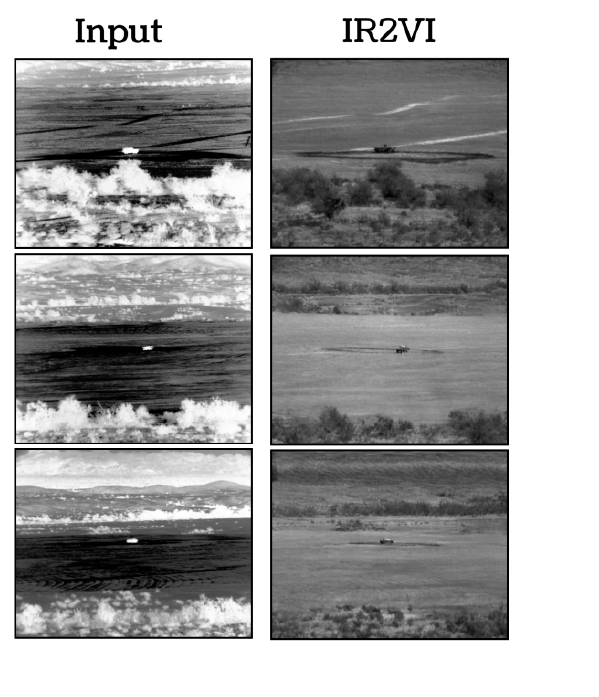
Figure 3. Infrared to visible range image translation were averaged over the entire object, losing the characteristic ther- mal